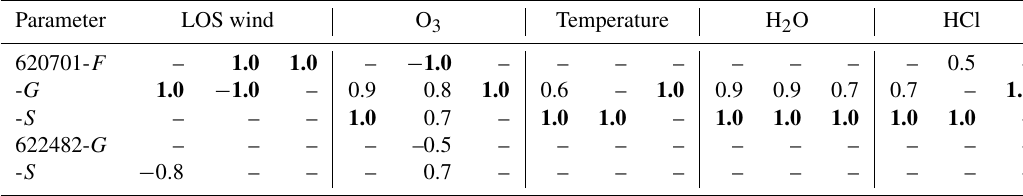
Table A4. Same as Table A1 but for the HCl line parameters. Parameter